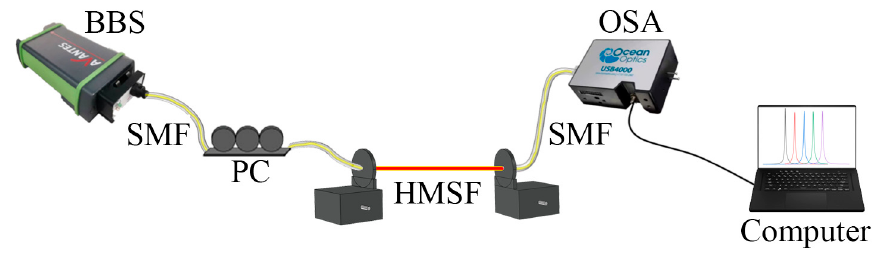
Figure 2. Schematic diagram of the experimental